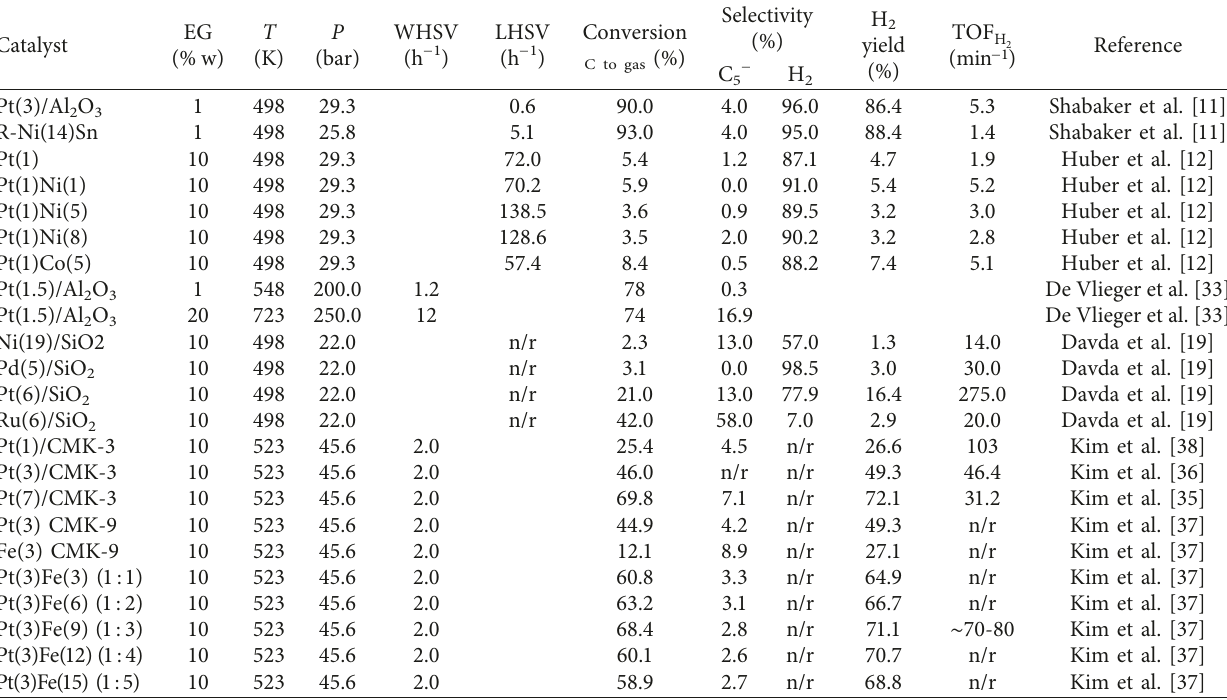
Table 4: Results of APR of ethylene glycol over different